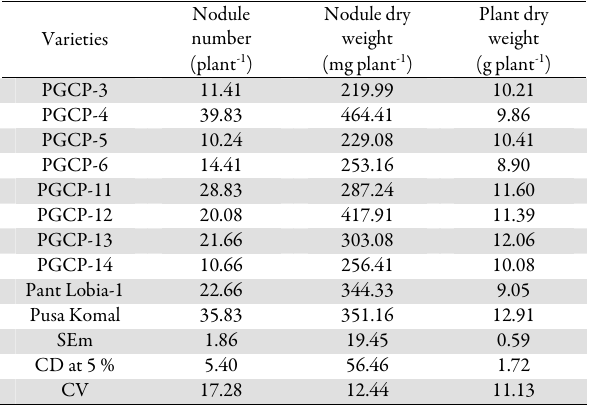
Tab. 1. Physiological characters of cowpea as influenced by cultivar differences